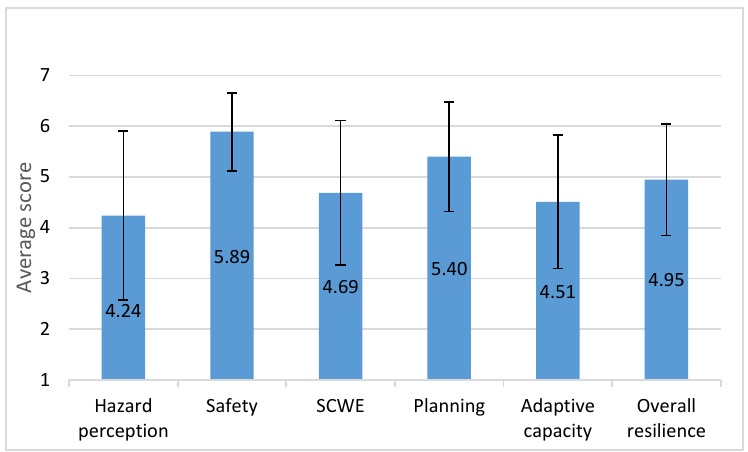
Figure 1. Scale averages with error bars (SD).